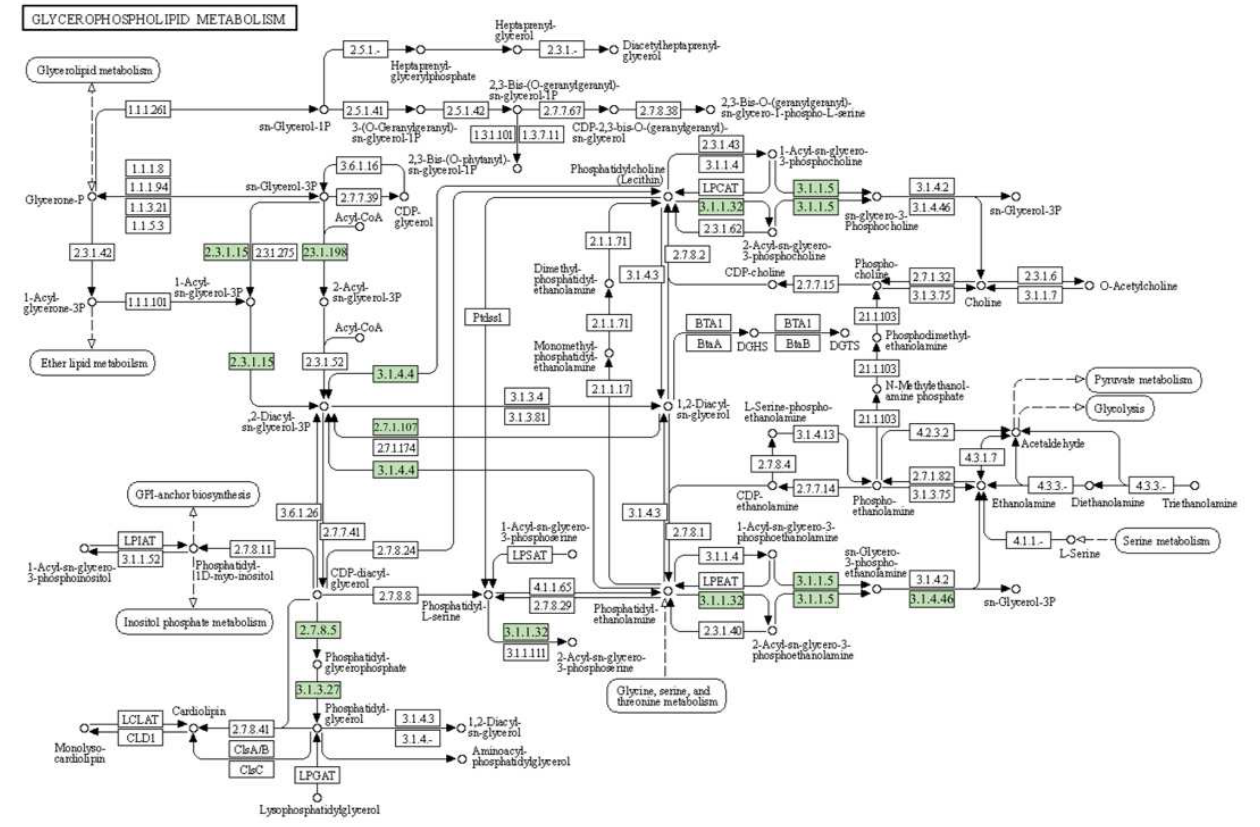
Figure 5. Overview of the glycerophospholipid metabolism pathways in sweet sorghum. Through the genes in the light green frames, we can see which pathways were involved among the key DEGs in both sweet sorghum genotypes. Table 1. DEGs mapped to KEGG pathways related to lipid metabolism.